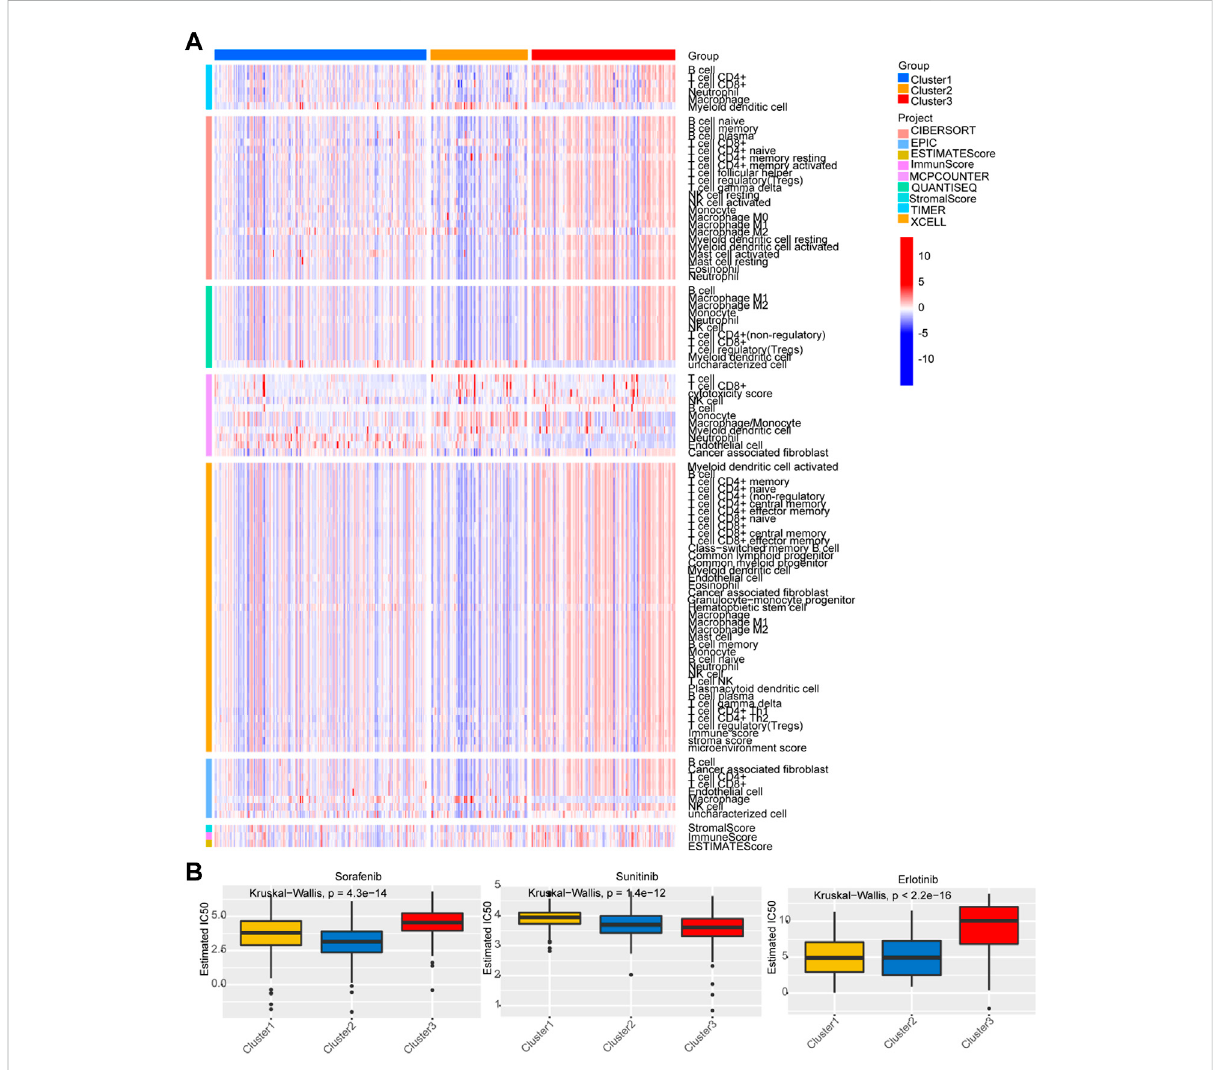
FIGURE 5 Analysis of immune status and chemosensitivity among the three subgroups. (A) Analysis of immune status. (B) Chemosensitivity analysis of three common chemotherapy drugs.